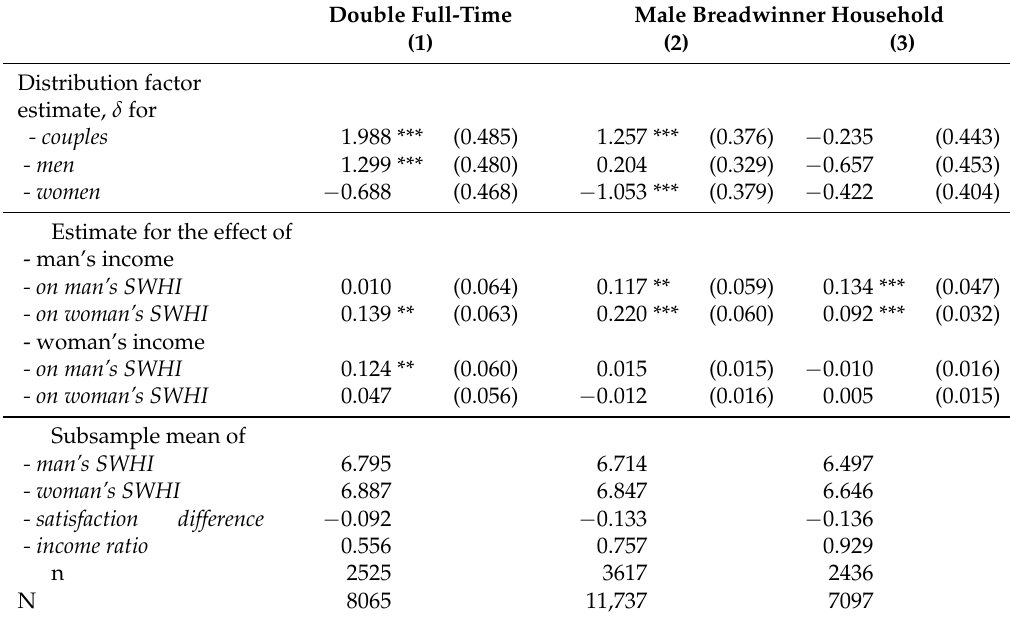
Table 3. Subsample